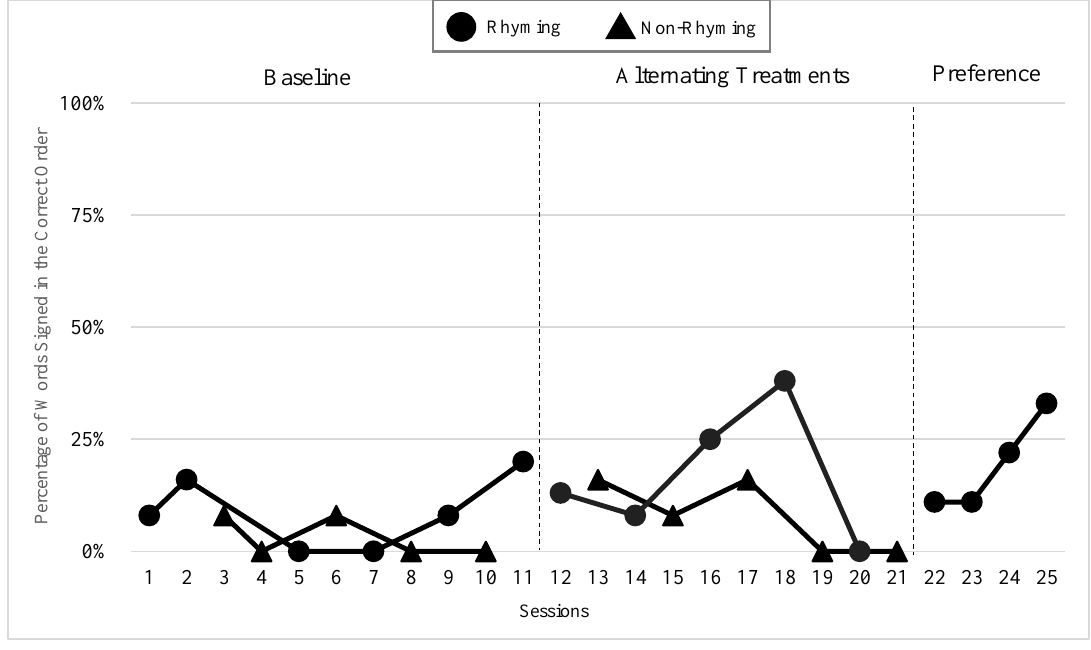
Figure 15. Lexie’s Percentage of Words Signed Correctly in Recitation.